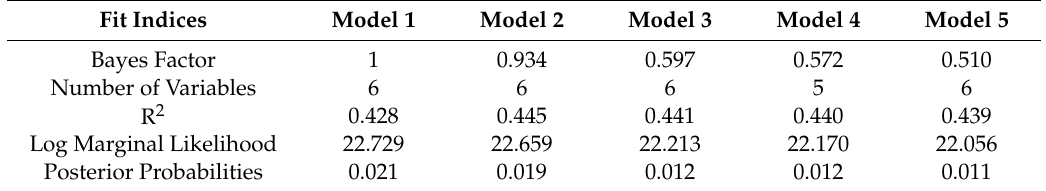
Table 2. Five best models for treatment as usual